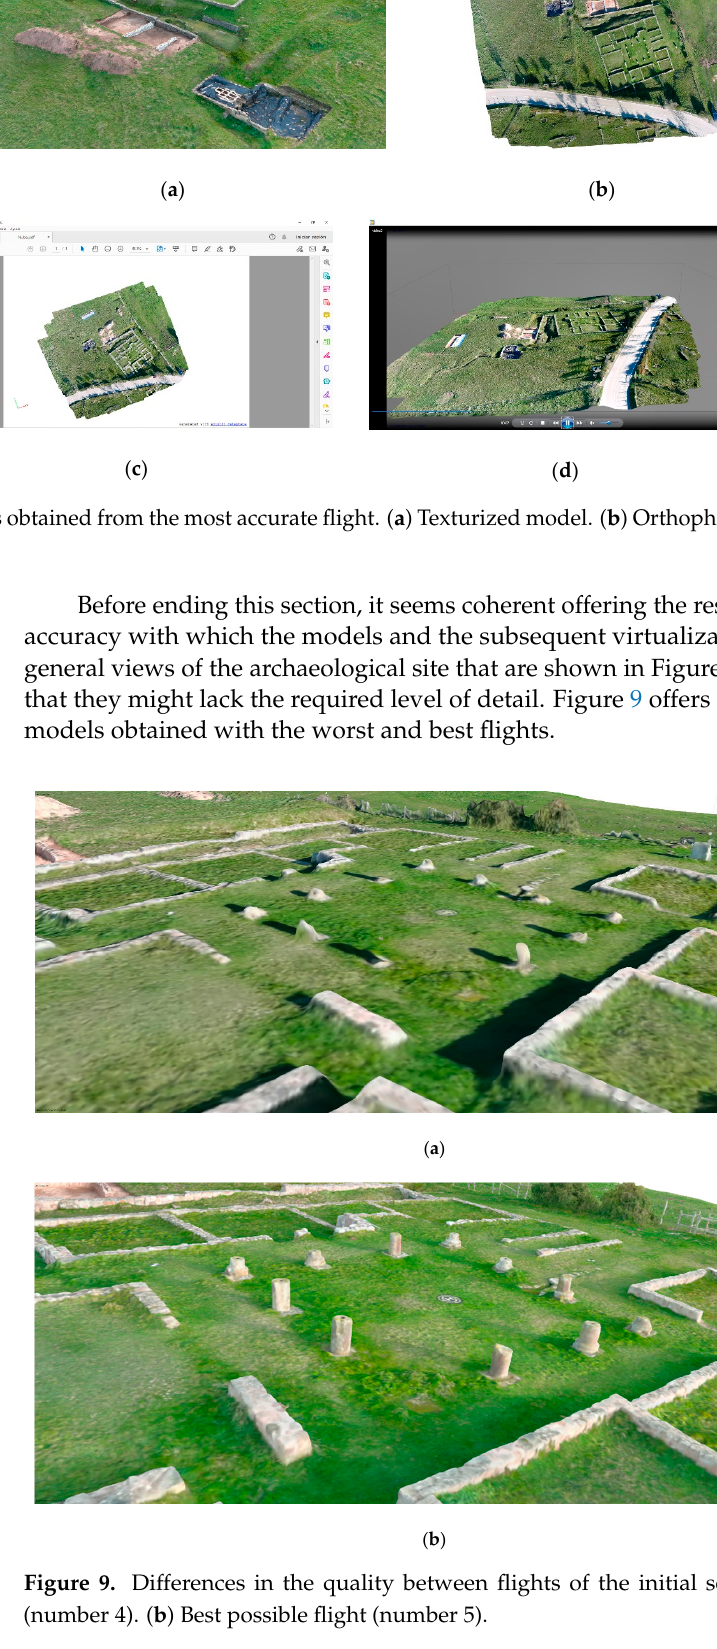
Figure 9. Differences in the quality between flights of the initial set. ( a ) Worst possible flight (number 4). ( b ) Best possible flight (number 5).